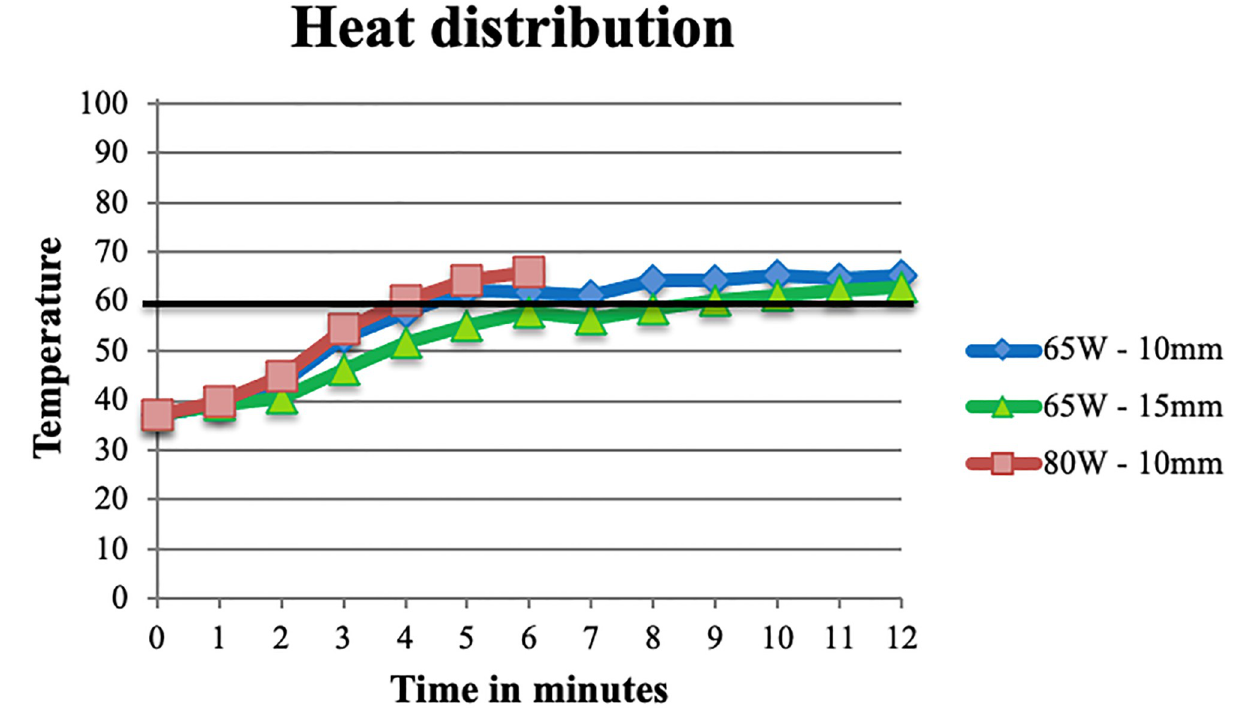
Fig 5. Heat distribution for in-vivo MWA in sheep femur. Blue = 65W—10mm, green 65W—15mm, red = 80W—10mm. Black line depicts the aimed temperature of 60˚C.